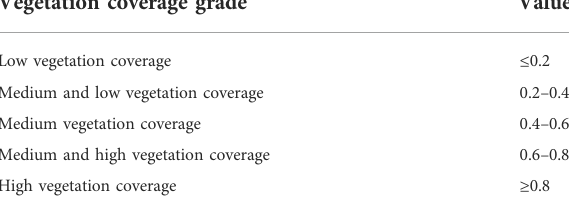
TABLE 2 NDVI grade of vegetation in the three northeast provinces.